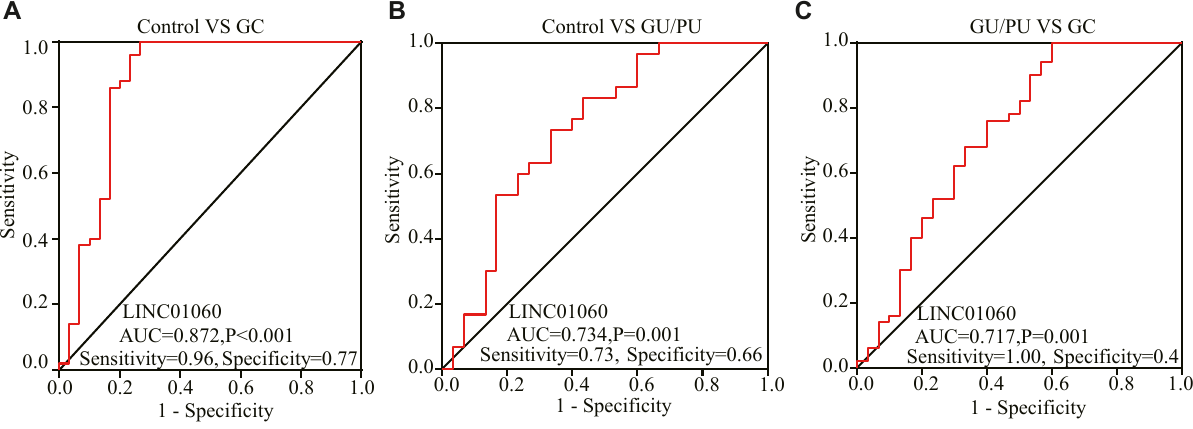
Figure 3: Receiver operating characteristic curves of LINC01060. (A) Diagnostic efficacy of whole blood LINC01060 in distinguishing between patients of gastric cancer and healthy controls. (B) Diagnostic efficacy of whole blood LINC01060 in distinguishing between patients of gastritis/peptic ulcer and healthy controls. (C) Diagnostic efficacy of whole blood LINC01060 in distinguishing between patients of gastritis/peptic ulcer and gastric